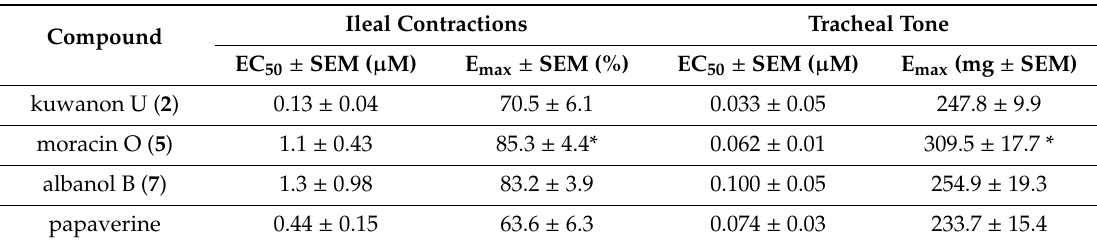
Table 2. Smooth muscle relaxant activity of compounds 2 , 5 and 7 on isolated rat ileum and trachea. EC 50 and E max values on the ileal contractions and tracheal tone are presented. Papaverine was used as a positive control on both experimental